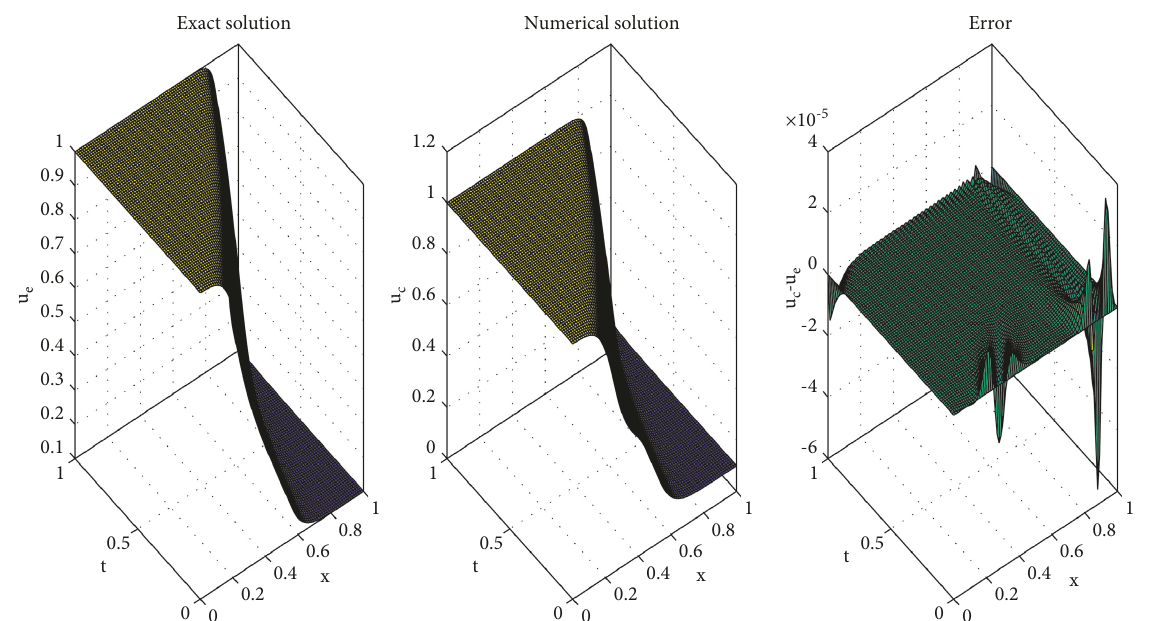
Table 9: Errors and convergence rates in the case of Chebyshev nodes with space interpolation parameter d m × n